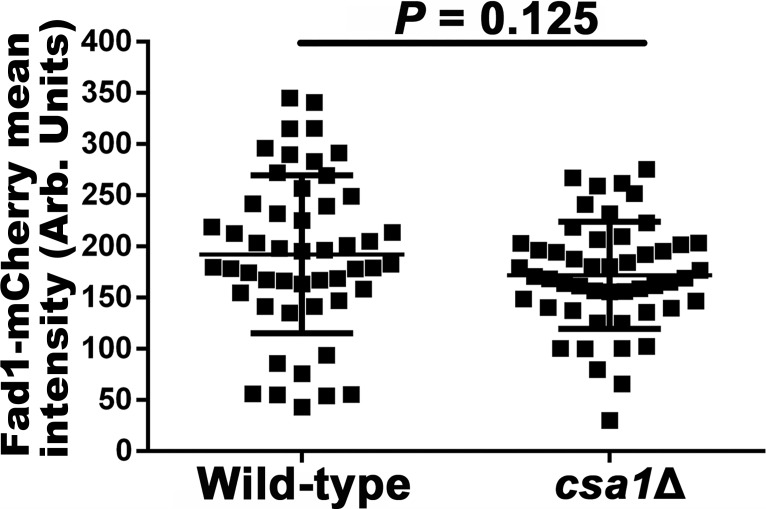
Fad1-mCherry expression was not significantly affected in the absence of Csa1.50 basidia expressing Fad1-mCherry were examined for each strain at 7 days post mating induction during unisex. Statistical significance was defined using two-tailed Student’s t test.10.7554/eLife.38683.024Figure 6—figure supplement 1—source data 1.Source file for Figure 6—figure supplement 1.